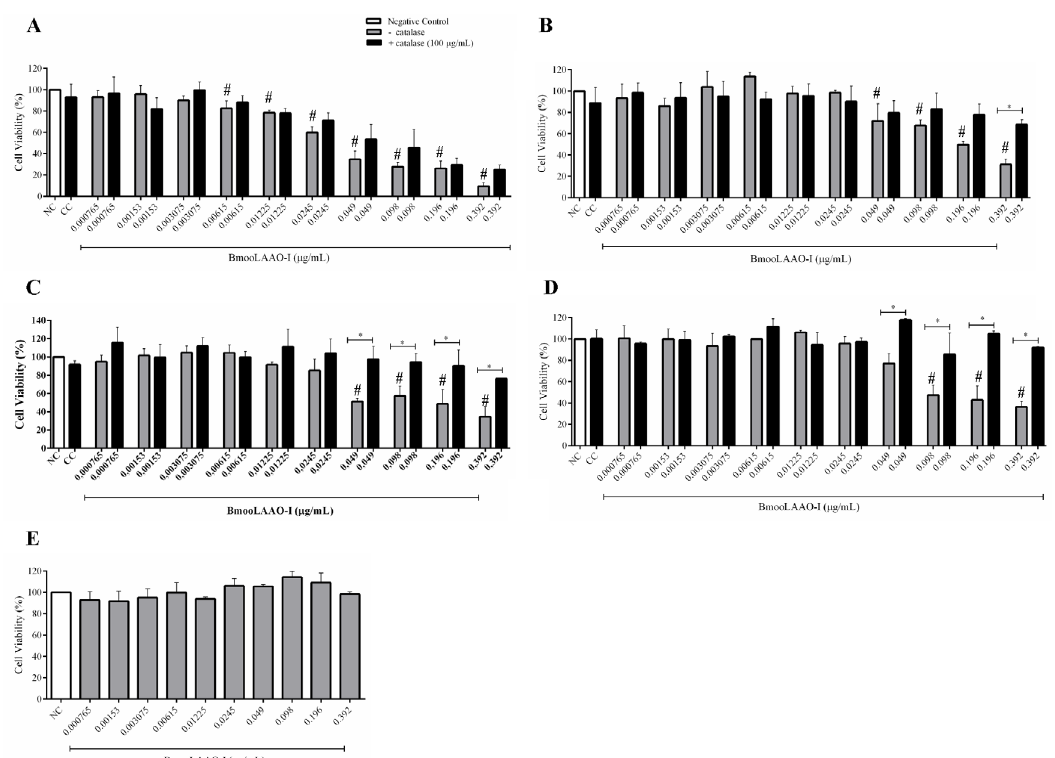
Figure 1. Cytotoxicity of BmooLAAO-I towards four tumor cell lines. (A) HL-60, (B) HL-60.Bcr-Abl, (C) K562-S, and (D) K562-R cells were treated with the toxin for 24 h, in the presence or absence of 100 μg/mL of catalase. (E) HEK-293 cells were treated with the toxin for 24 h only without catalase due to the lack of cytotoxicity of BmooLAAO-I towards this cell line. Results are expressed as mean ± standard deviation of the percentage of cell viability from three independent experiments assayed in triplicate. NC: negative control (untreated cells); CC: catalase control (cells treated only with catalase). # p < 0.05 vs. NC; * p